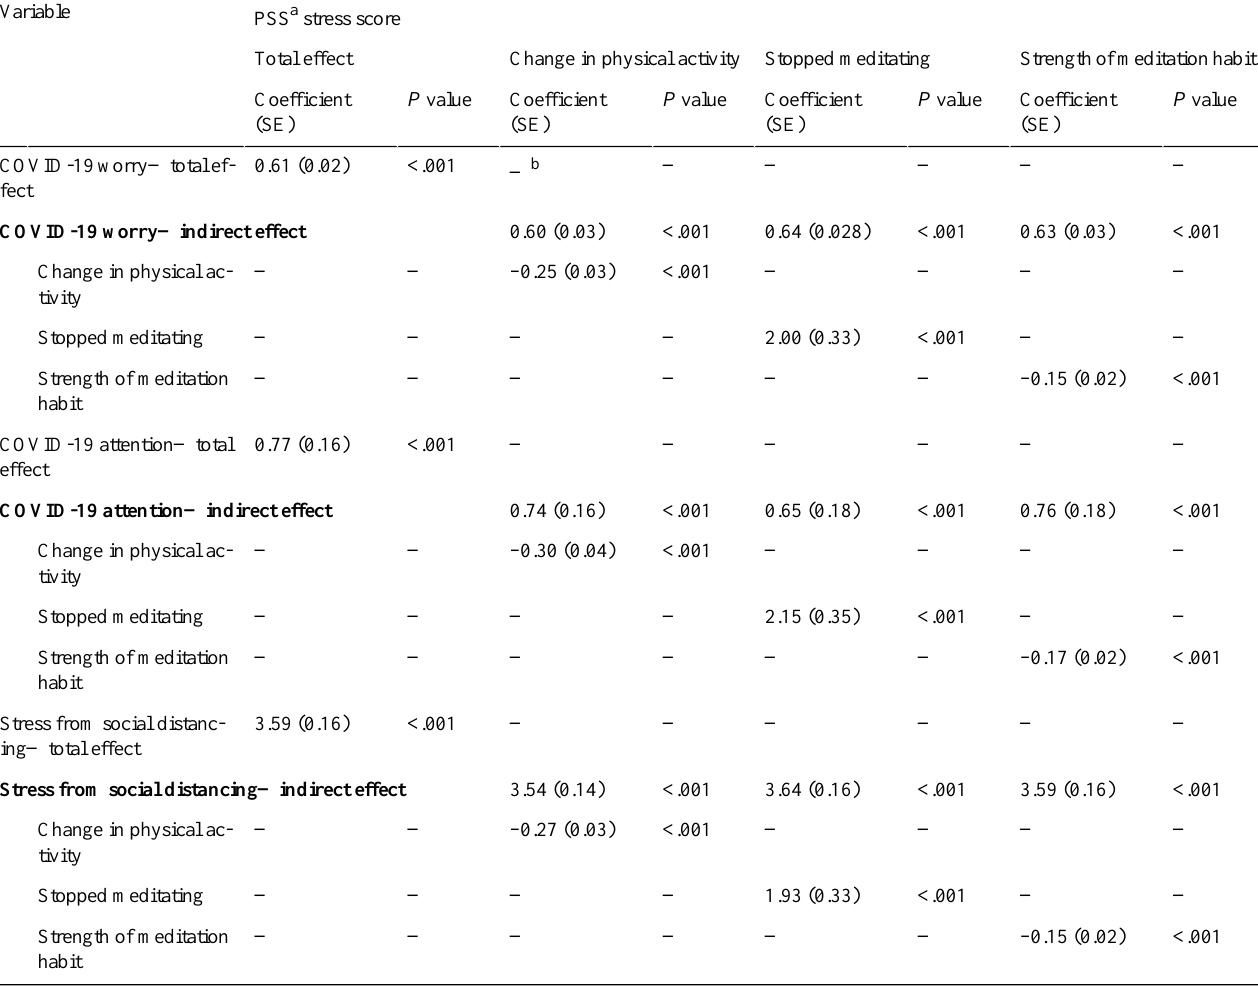
Table 6. Mediating effect of health behavior change on stress. The table presents the coefficients from ordinary least squares regression models of PSS stress score on COVID-19 worry, COVID-19 attention, and stress from social distancing as well as the indicated health behavior changes. The demographic variables of age, male sex, Hispanic, income <US $80,000, income US $81,000-100,000, unemployed, and underlying medical condition were included as covariates in all models, which also estimated heteroscedasticity-robust standard